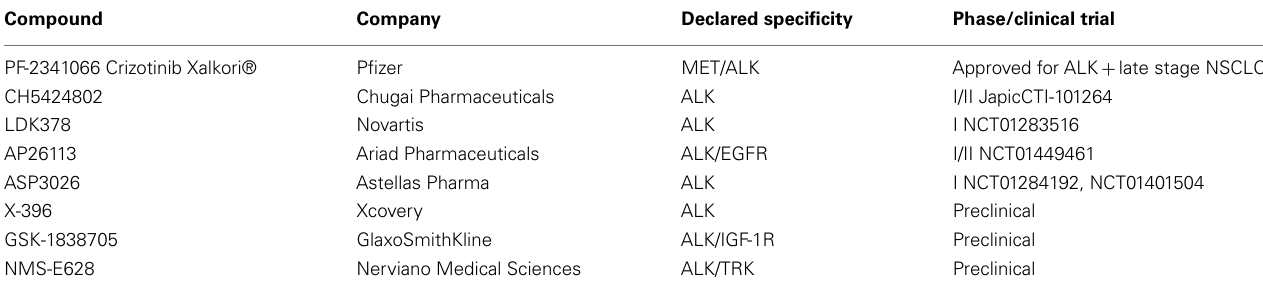
Table 1 |ALK small molecule